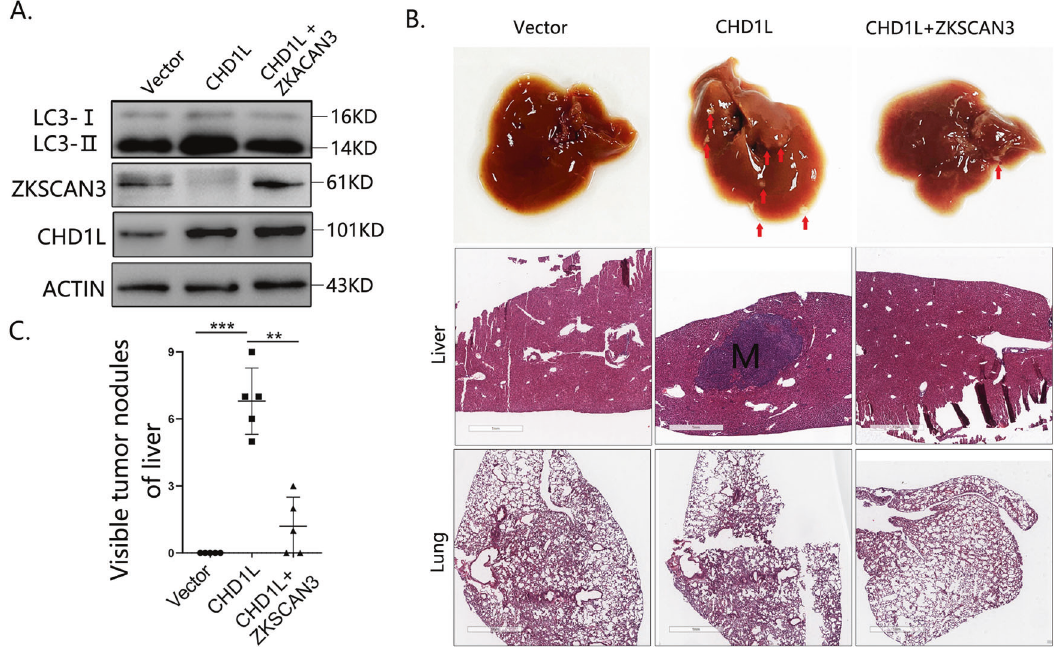
Supplementary Table 2. 3-MA (HY-19312) were purchased from Med- ChemExpress. The plasmid of PXN (Genebank: NM_001080855) and its corresponding Control were provided by